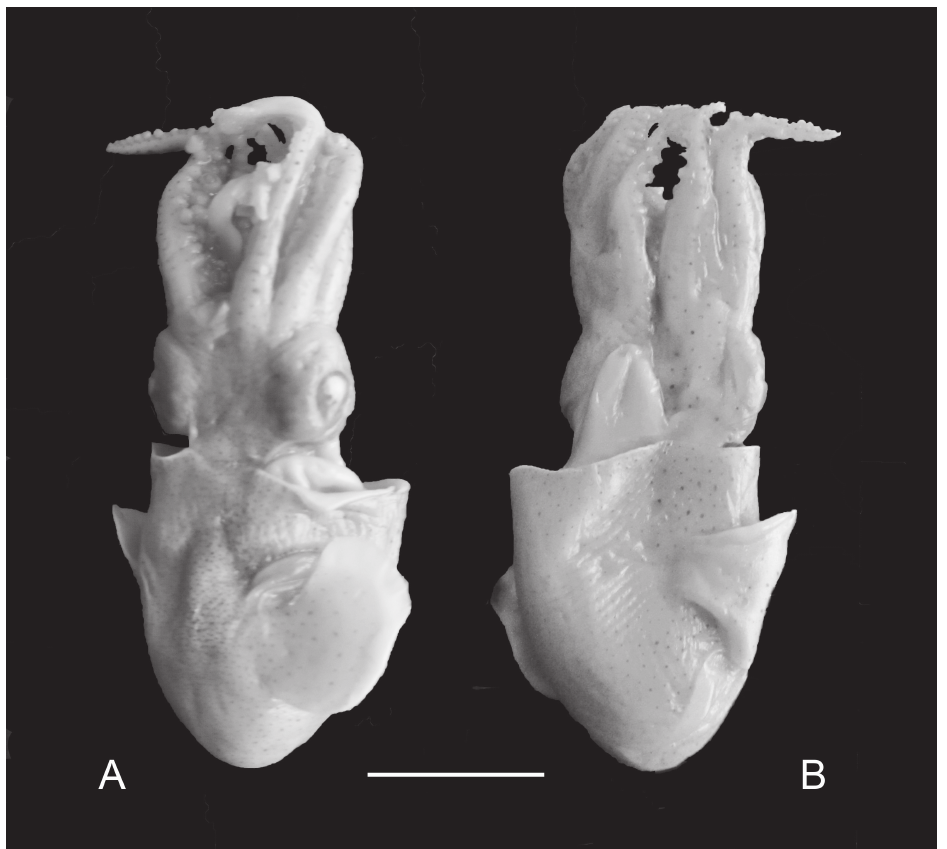
Fig. 2. Sepiola boletzkyi sp. nov., holotype, ♂, ESFM-CEP/1994-1. The hectocotylus was removed for closer examination. A . Dorsal view. B . Ventral view. Scale bar = 1